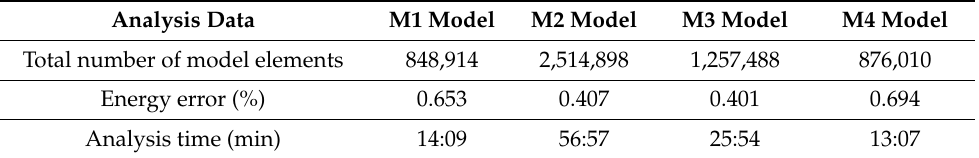
Table 1. Comparison of 3D Finite Element Analysis